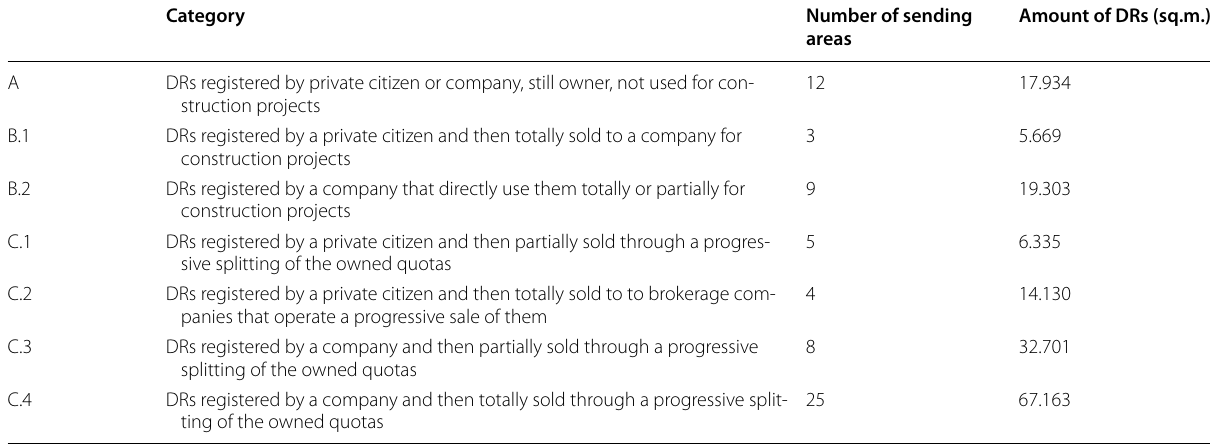
Table 1 Summary of the main cases highlighted on the Milan DRs market Category Number of sending